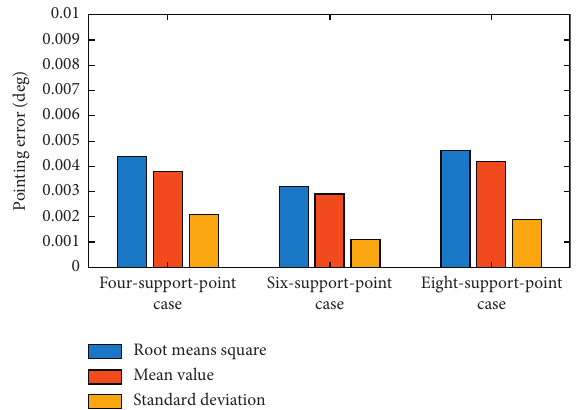
Figure 15: Summary of telescope pointing error statistics